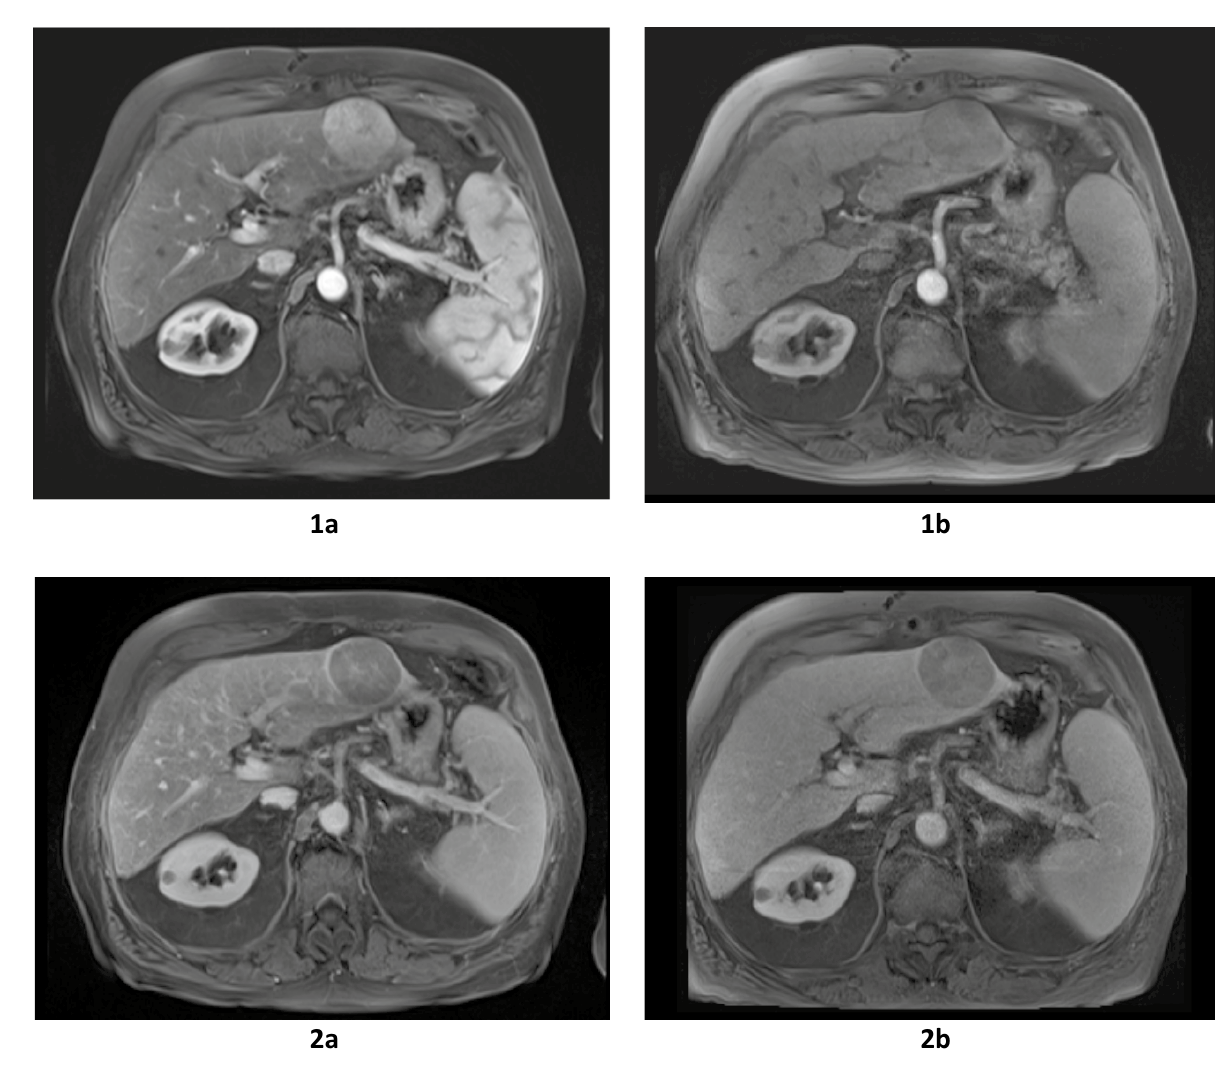
Figure 3. Major imaging features of LI-RADS v2018 (APHE and enhancing capsule) after administration of gadoteric acid and gadoxetic acid. Figures ( 1a,2a ) demonstrates the stronger APHE during the arterial Phase ( 1a ) and enhancing capsule in the portal venous phase ( 2a ) after administration of the extracellular contrast agent gadoteric acid than with the hepatocyte-specific contrast agent gadoxetic acid ( 1b,2b ). APHE arterial phase hyperenhancement, PVP portal venous phase, LI-RADS Liver Imaging Reporting and Data